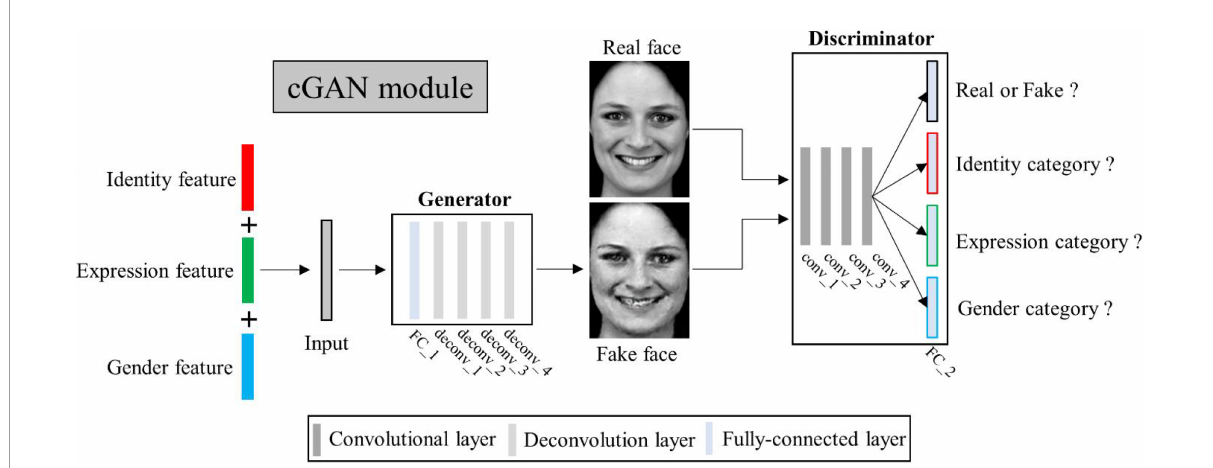
FIGURE3 Illustration of multi-conditional generative adversarial network (mcGAN) module